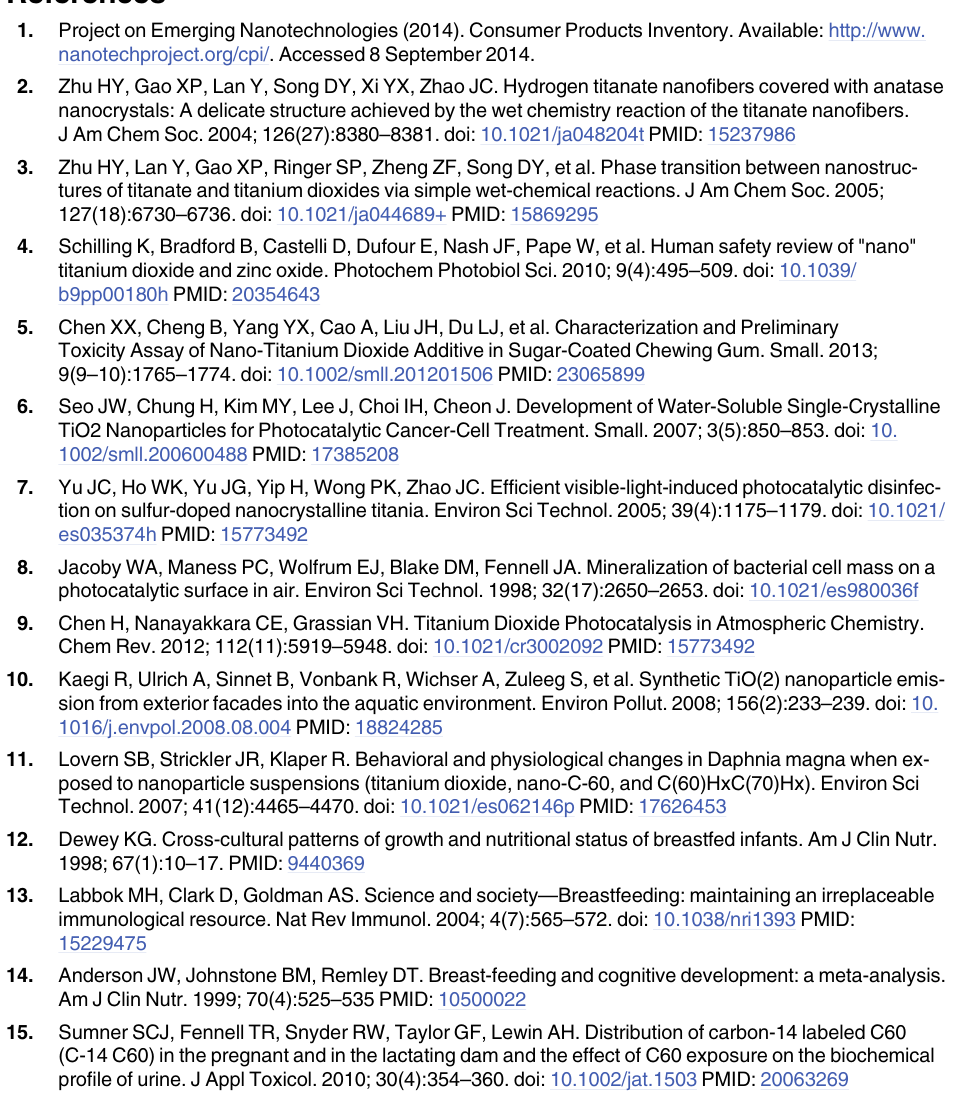
S1 Table. Blood biochemistry (A) and hematology (B) of dams after TNP-8 and -50 expo- sure (8 mg/kg) at LD